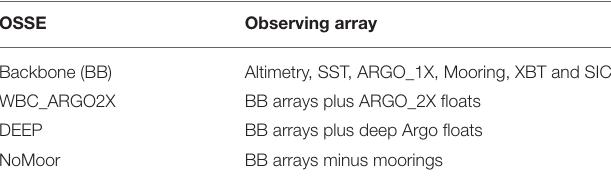
TABLE 1 | OSSEs with data assimilation at the Met Office. OSSE Observing array Backbone